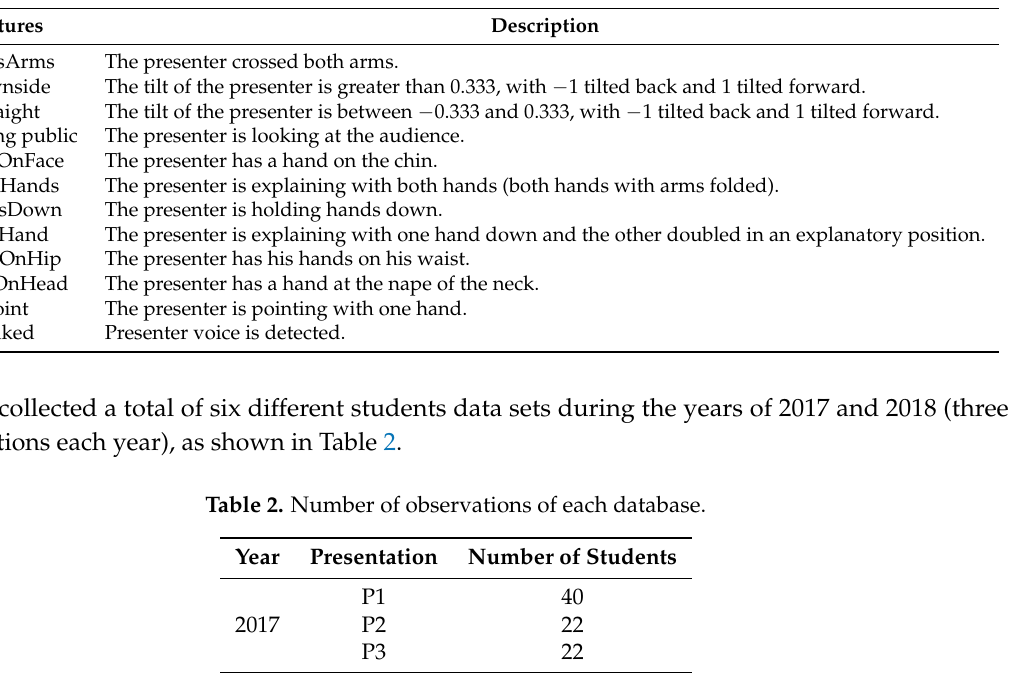
Table 1. Description of each characteristic of the databases.